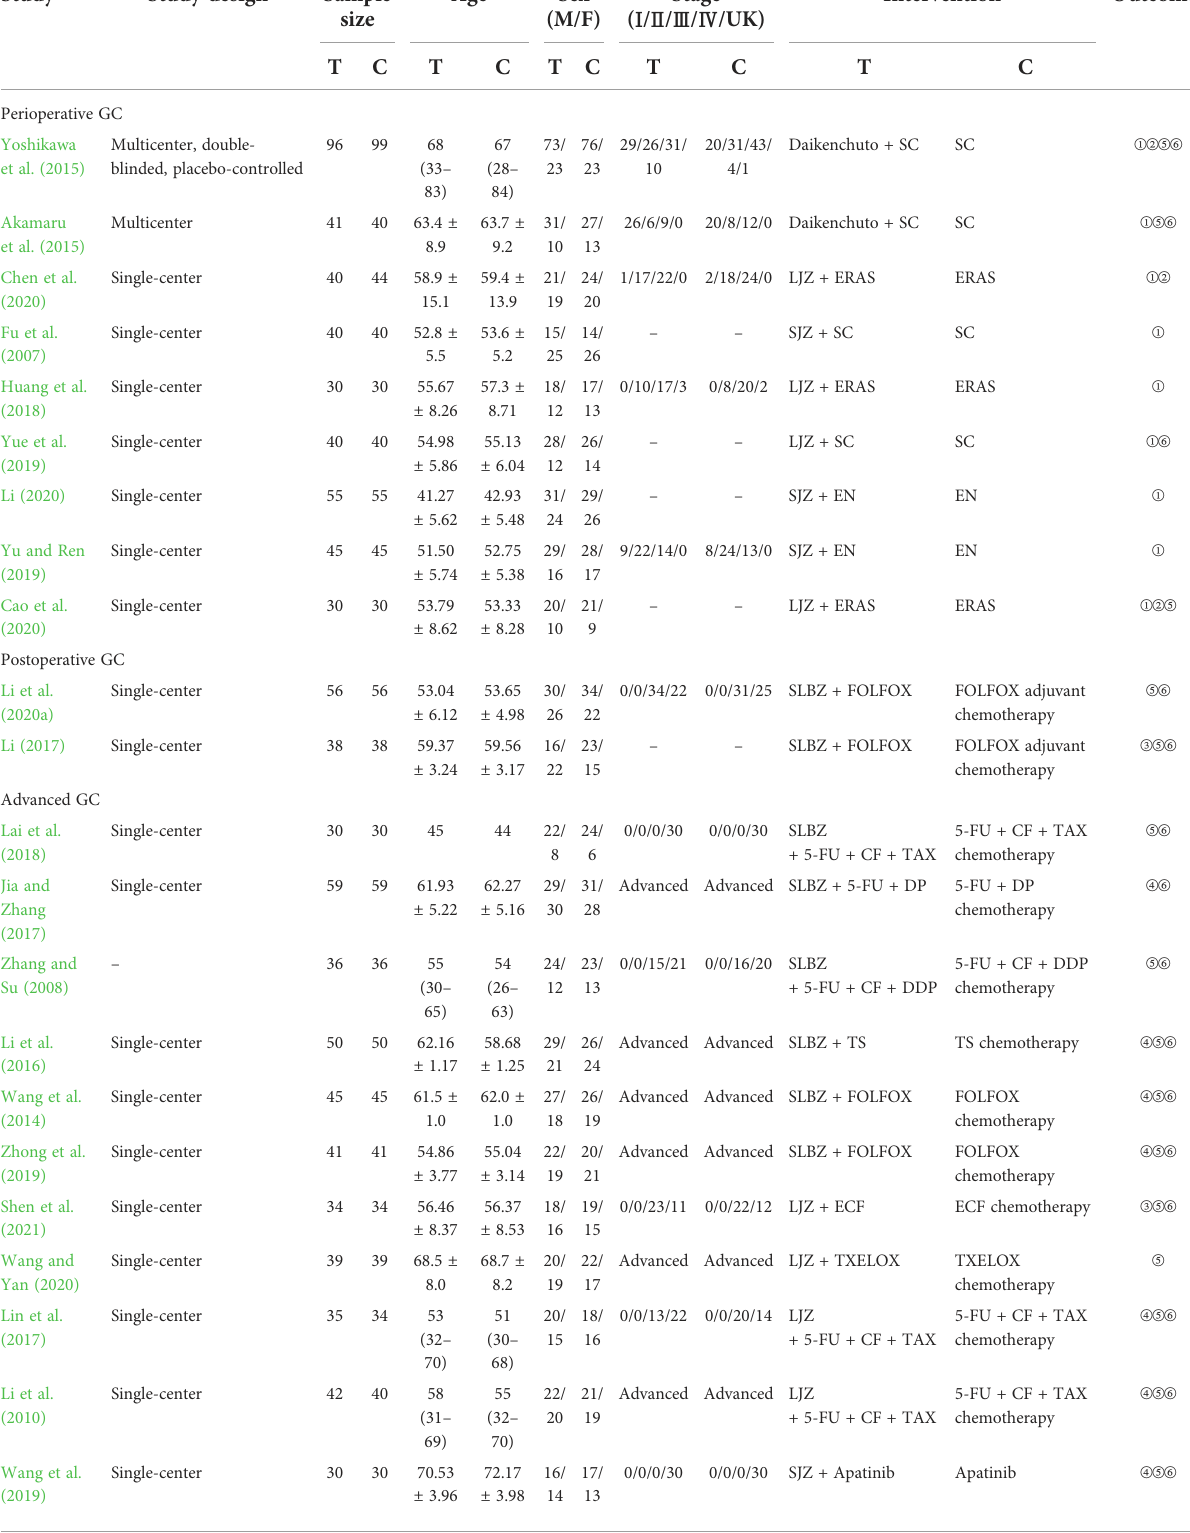
TABLE 1 Study characteristics of included